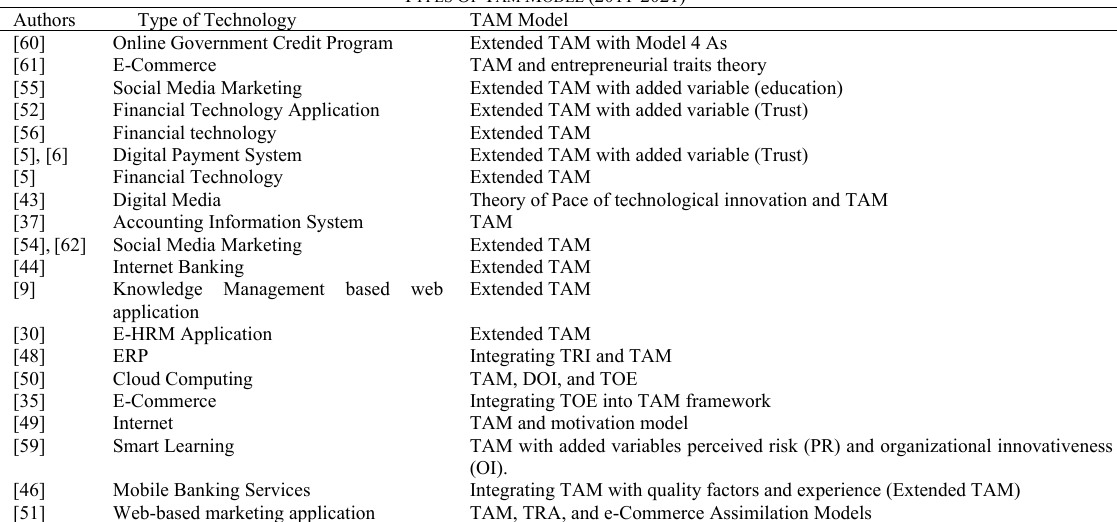
Fig. 5 Type of TAM used to study technology adoption on SMEs TABLE 3 T YPES O F T AM M ODEL